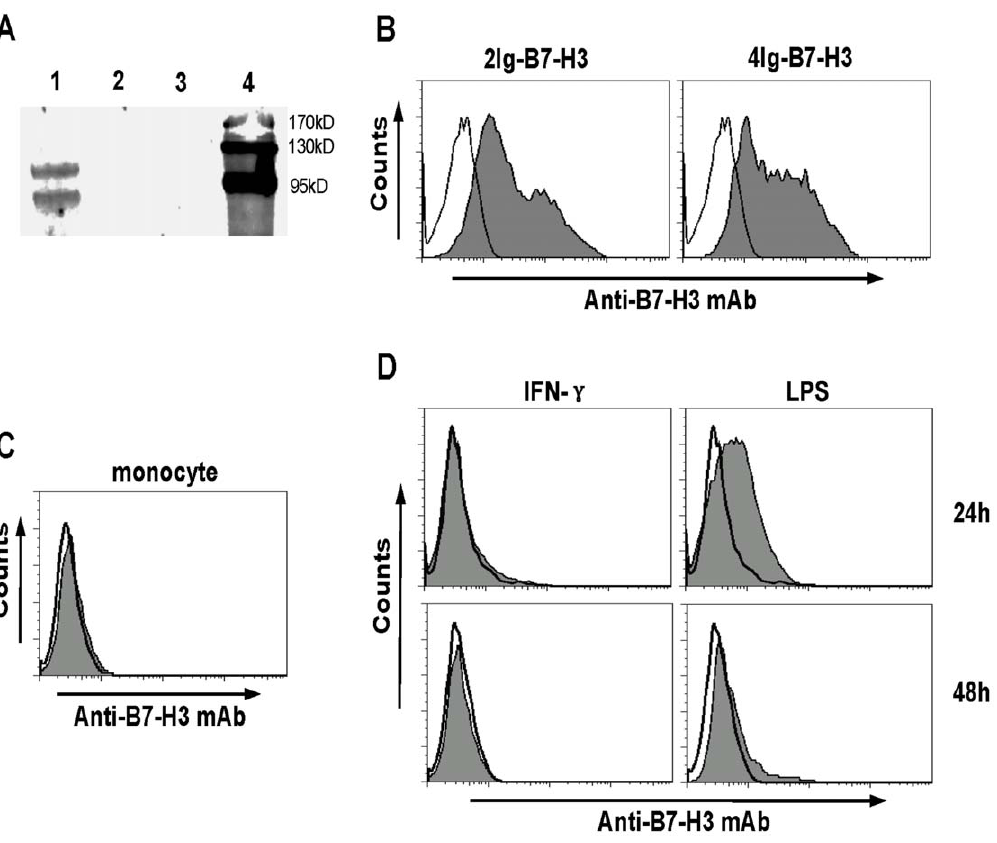
Figure 5. Analysis of porcine B7-H3 expression on monocytes. A, Immunoprecipitation assay. The membrane protein extracted from the porcine 4Ig-B7-H3-transfected 293 T cells (Lane 1) or vacant plasmid-transfected 293 T cells (Lane 2) was pulled down with anti-porcine B7-H3 mAb- bound protein-G agarose. The pulled-down proteins were submitted to western-blot assay. Lane 3: anti-porcine B7-H3 mAb-bound protein-G agarose control. Lane 4: protein marker. B, The analysis of the porcine 2Ig-(left plot) and 4Ig-B7-H3 (right plot) expressed on 293 T cells stained by the anti- porcine B7-H3 mAb (filled histogram) or isotypic Ab (open histogram). C, non-activated monocytes were stained with a combination of anti-CD14 with either anti-B7-H3 mAb (filled histogram) or isotypic Ab (open histogram). D, The monocytes were co-cultured with IFN- c in a final concentration of 30 ng/ml (left plots) or LPS at a final concentration of 1 m g/ml (right plots) for 24 h (upper plots) or 48 h plots (lower plots). On the indicated time points, the monocytes were harvested to be stained with a combination of anti-CD14 with either anti-B7-H3 mAb (filled histogram) or isotypic Ab (open histogram).